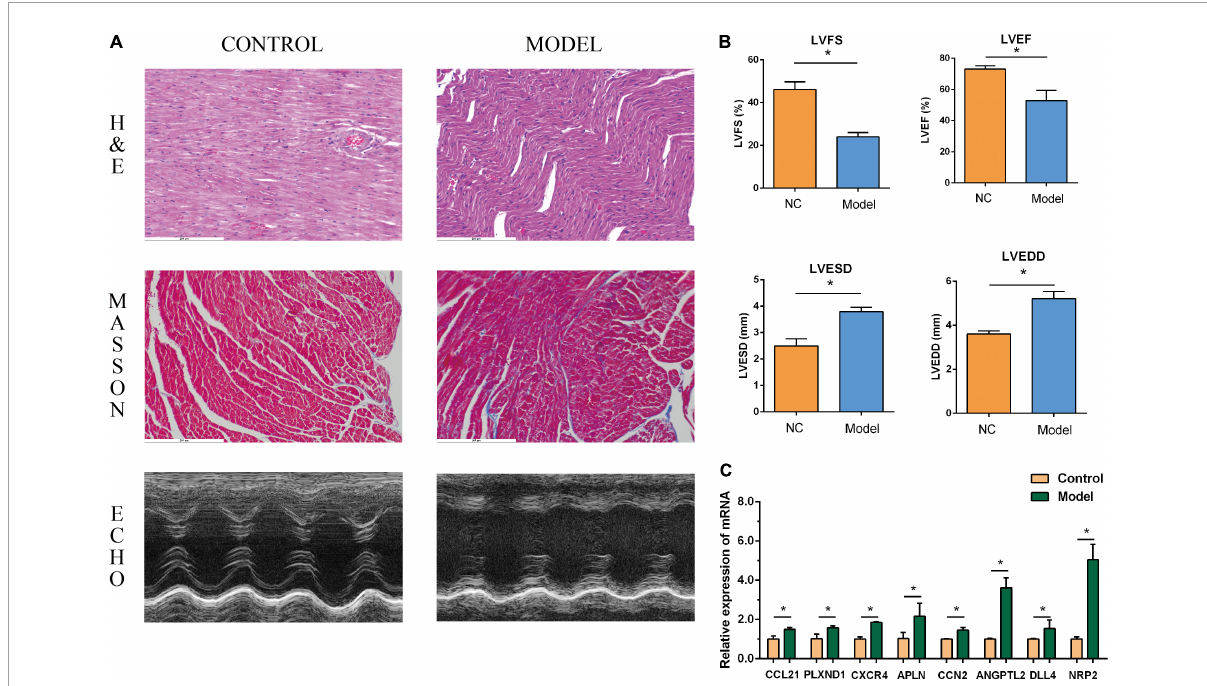
FIGURE9 Myocardial injury and impaired heart function were assessed in Type 2 diabetic heart failure mice model. (A) Representative pictures of HE staining, Masson staining, and echocardiography (magnification, 400 × ). (B) Comparison of LVEDS, LVEDD, LVEF, and LVFS between the control group and the model group. (C) Relative mRNA expression of each core gene in control group and model group. * P <